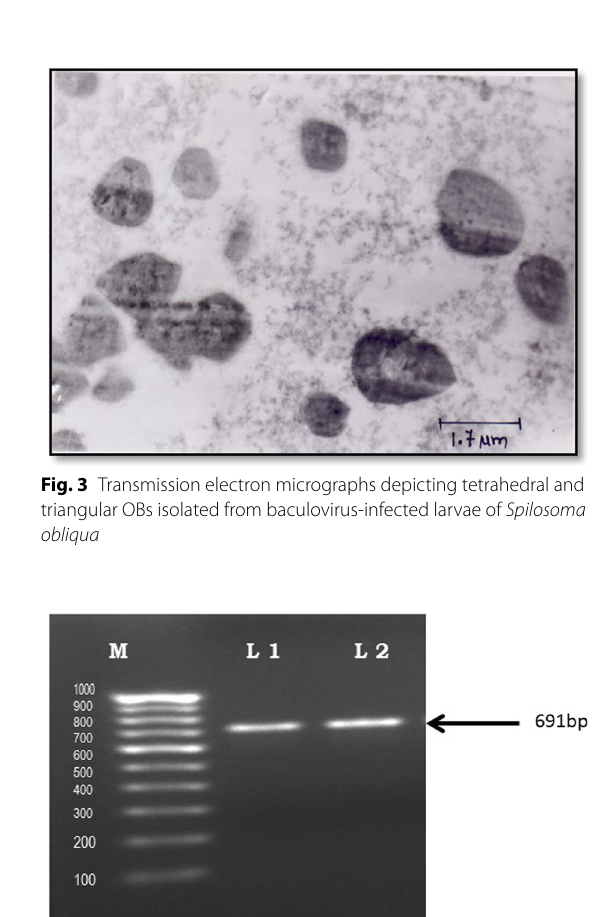
Fig. 2 Scanning electron micrographs depicting tetrahedral and triangular polyhedral OBs isolated from baculovirus-infected larvae of Spilosoma obliqua